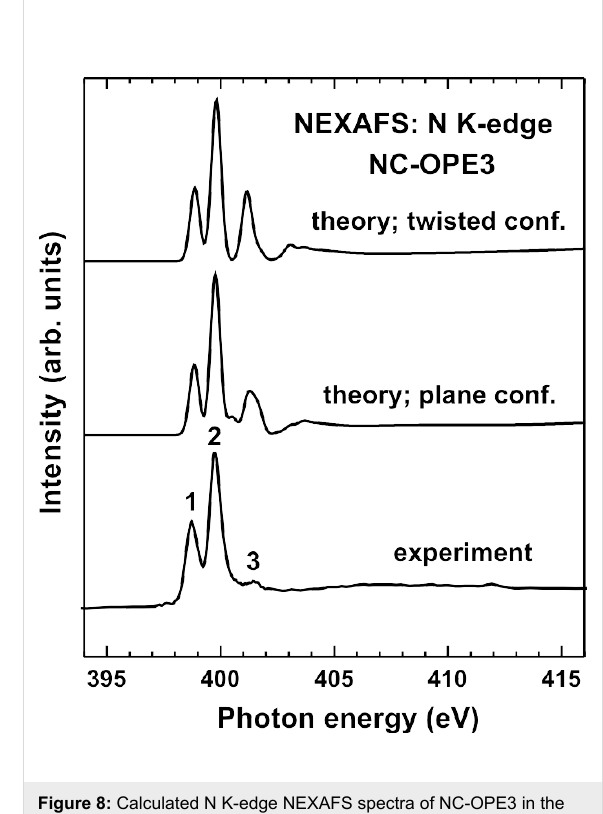
Figure 8: Calculated N K-edge NEXAFS spectra of NC-OPE3 in the planar and twisted conformations, along with the experimental spec- trum of NC-OPE3/Au taken at an X-ray incidence angle of 55°. The theoretical spectra were shifted by ca. 2.3 eV to lower photon ener- gies in order to align the most intense π * resonances in the theoretical and experimental spectra. The most prominent absorption resonances in the experimental spectrum are marked by